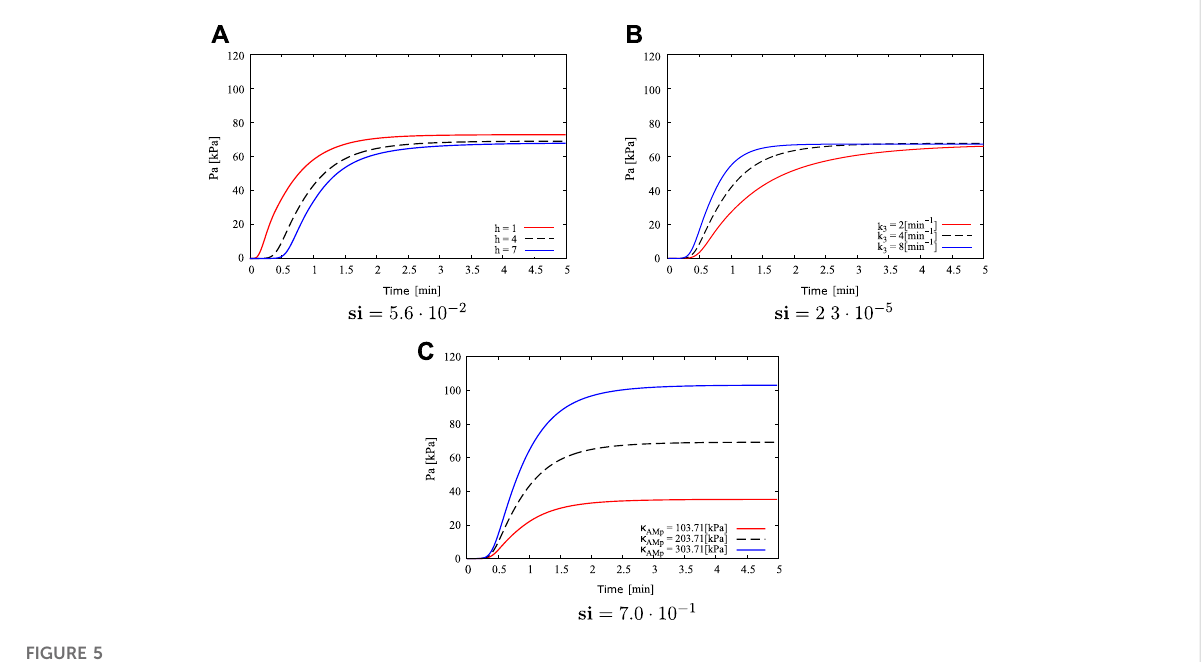
FIGURE 5 Sensitivity analysis for parameters: (A) h , (B) k 3 and (C) κ AMp , regarding to active stress P a , and its corresponding si value.